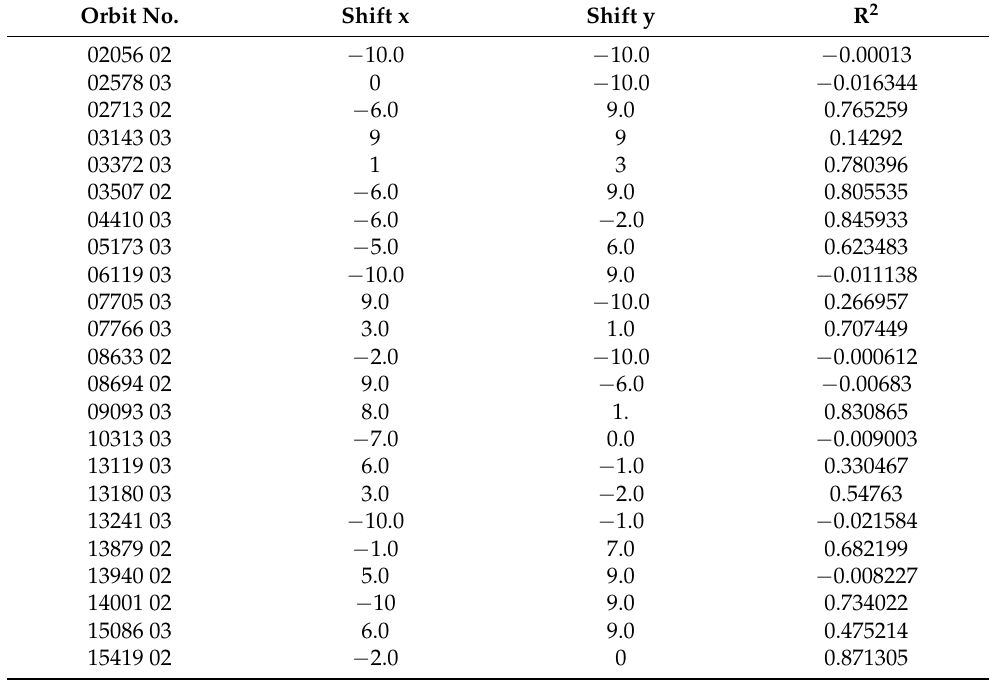
Table A1. Offset values per orbit as applied in the GEDI co-location step. Orbit